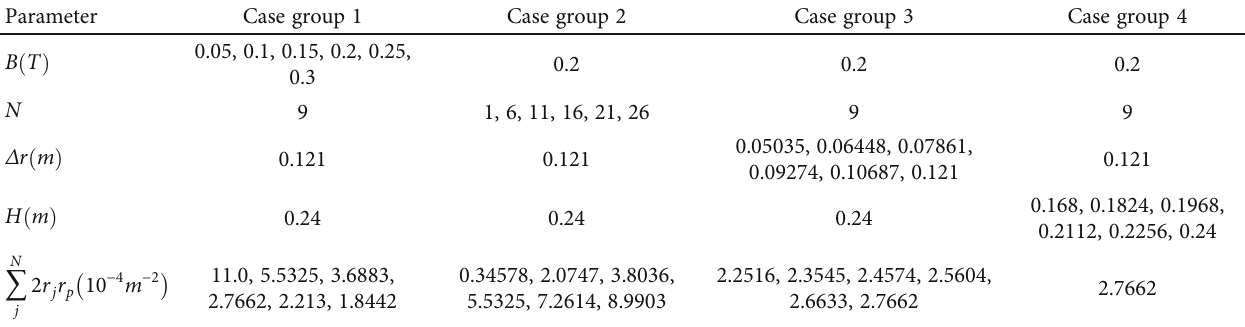
Table 2: The case group setting for circumferential distribution of primary